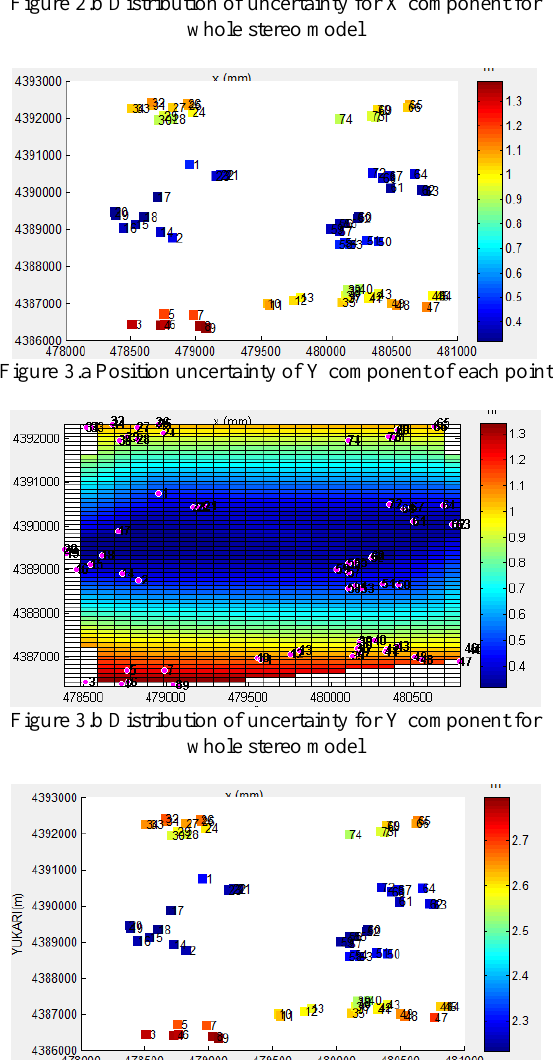
Figure 5.a Effect of orientation parameters on X